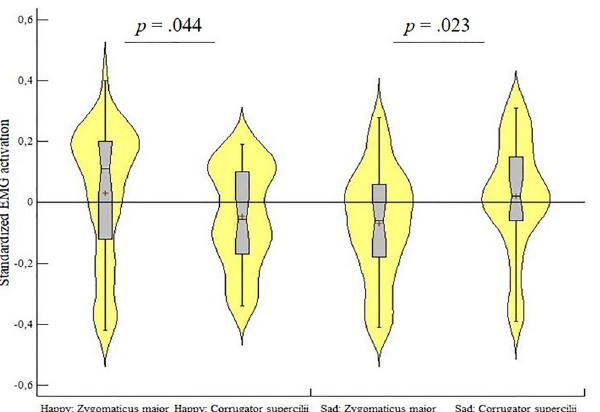
Fig 3. EMG activation violin plots. Violin plots illustrating the standardized EMG activation in the zygomaticus major and corrugator supercilii muscles, in response to happy and sad stimuli. The distribution of the data is represented by the violin shape, with larger width indicating higher value frequency. The mean of each muscle in each condition is represented by a plus sign, whereas the horizontal bars represent the minimum, the median and the maximum values. The whiskers represent the first and the fifth